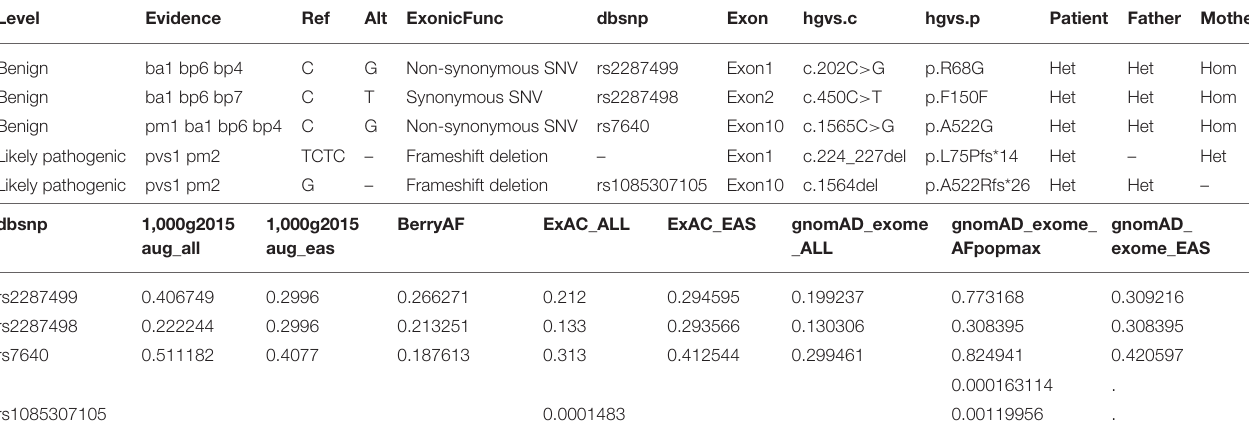
TABLE 3 | Family sequencing for genotype of the WRAP53